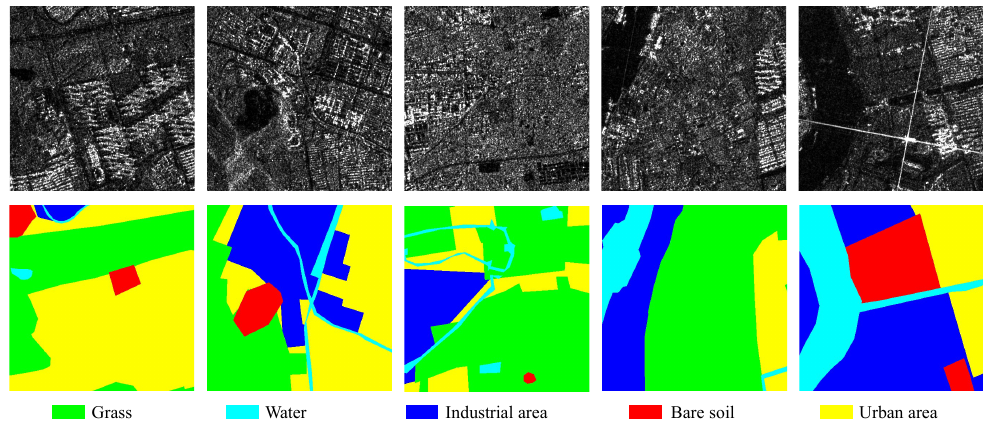
Figure 3. Partial training dataset of multi-task feature